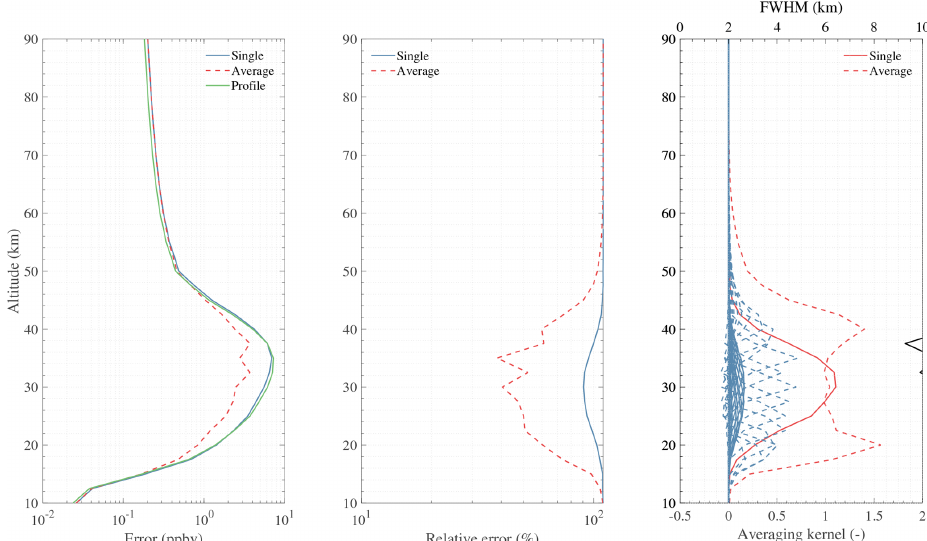
Figure 26. Simulation result of NO 2 retrieval using 232.7GHz lines. “Single” and “Average” represent the retrieval error using different noise. “Profile” represents the typical profile used in the simulation. The black solid line in the last panel represents the FWHM (i.e. vertical resolution).